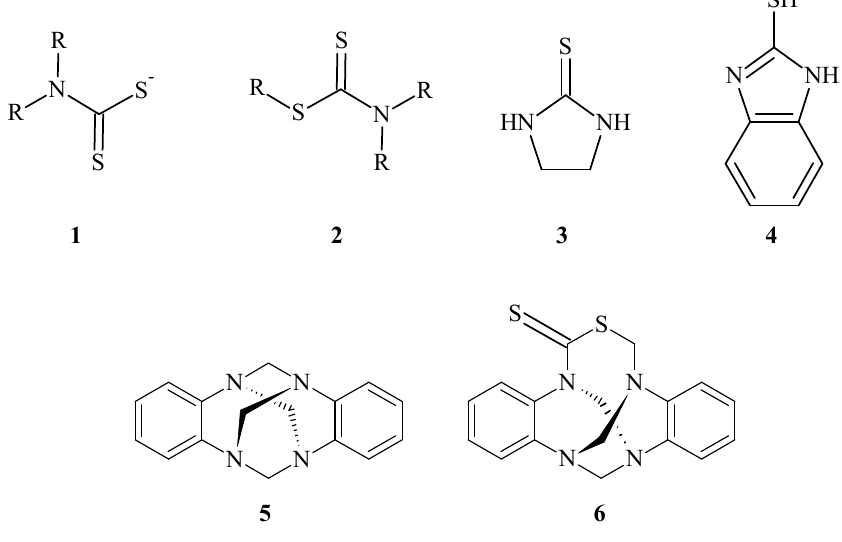
Figure 1. The chemical structures of compounds 1 – 6 .